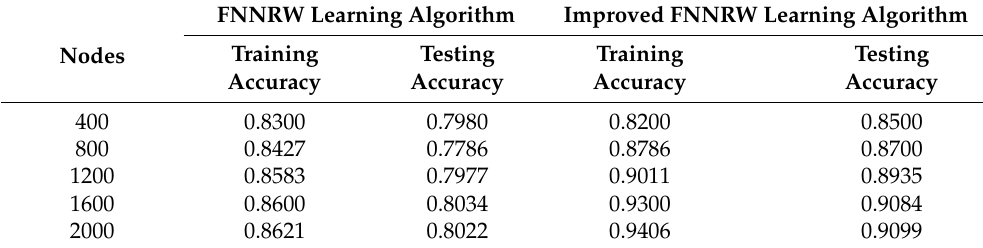
Table 1. Training accuracy and test accuracy of the FNNRW learning algorithm and the optimized FNNRW learning algorithm when samples are divided into 10 subsets. We partitioned the entire huge dataset into 10 smaller datasets, using the training set and test set to examine how well the improved method performed. The accuracy of each dataset is displayed in the table.